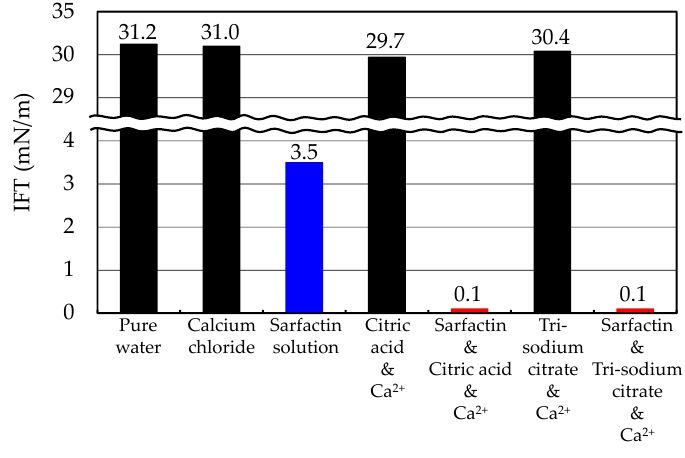
Figure 5. IFT between the crude oil and each solution.